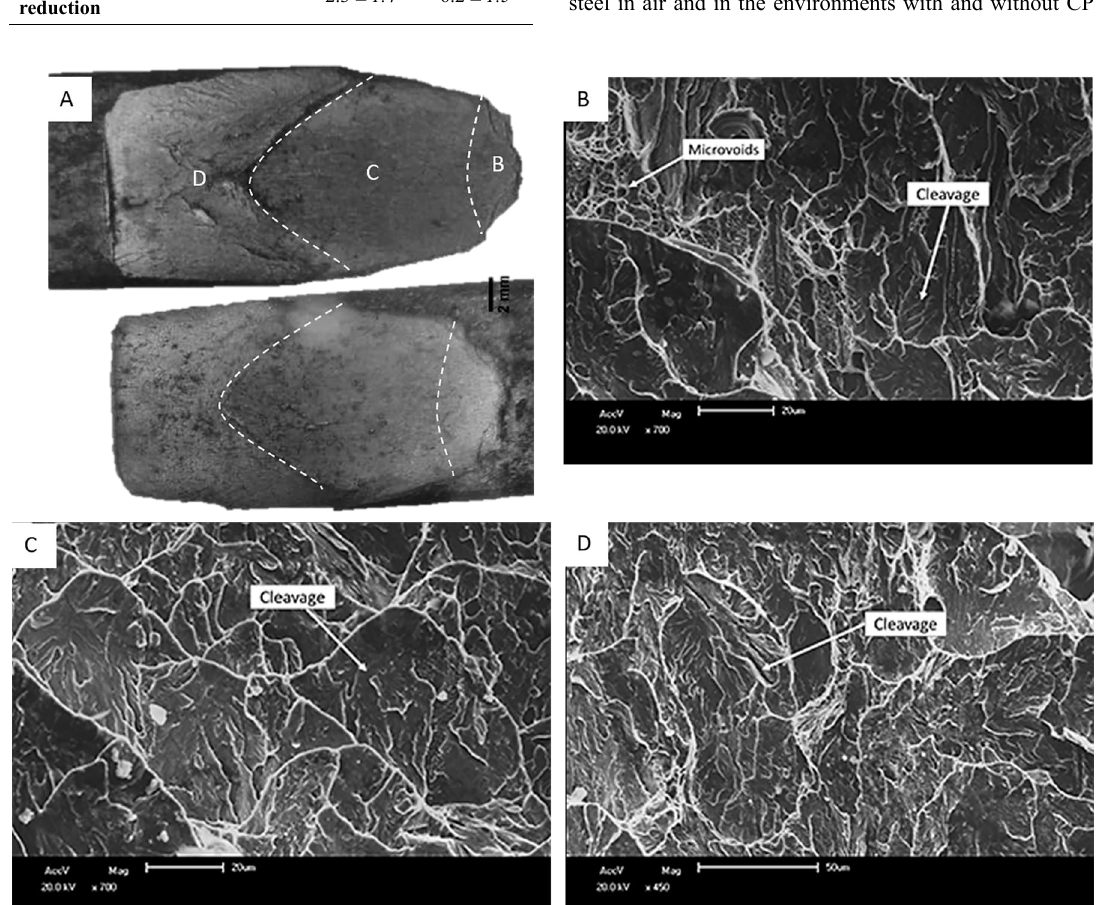
Figure 8. SEM analysis from pearlitic-ferritic material in environment with CP: (A) Overall fracture surface; (B) Initiation region; (C) Propagation region; and (D) Final fracture